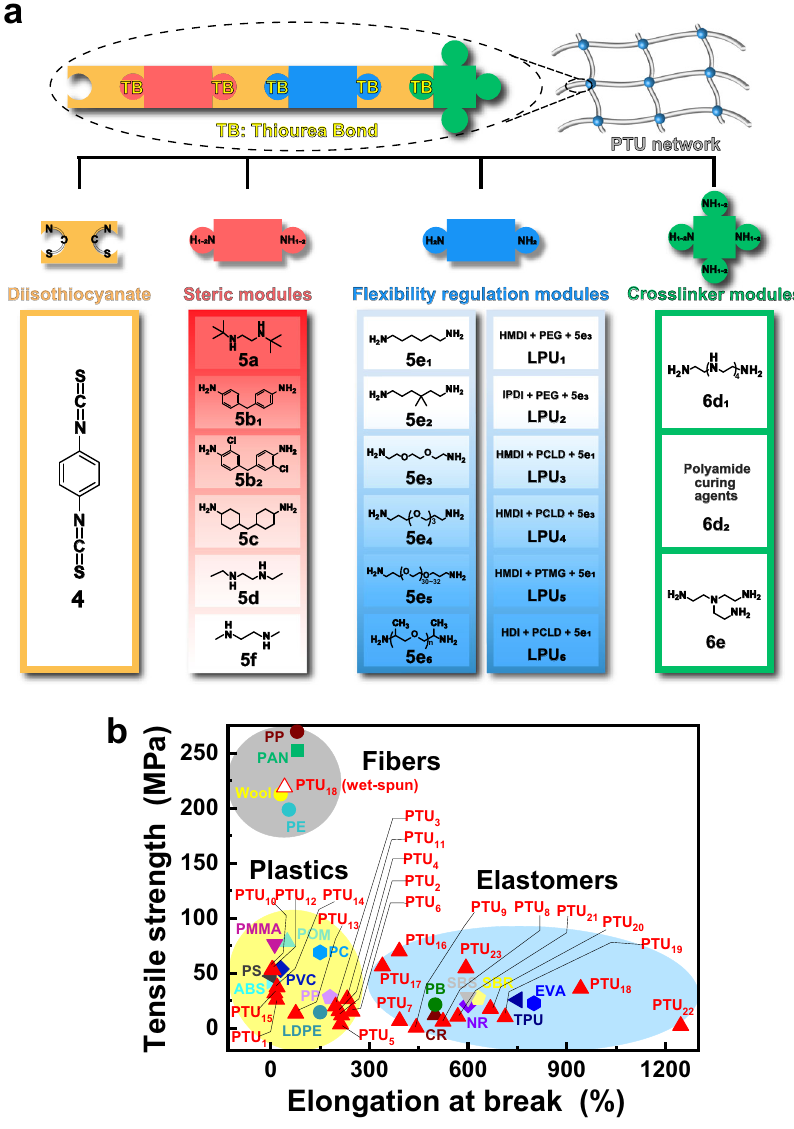
Fig. 2 Synthesis and mechanical characterization. a Modular assembly-like synthesis of crosslinked PTUs, and chemical structures of the designed modules. Note: The darker background colors of the boxes for steric modules and fl exibility regulation modules indicate larger steric hindrance, and greater ability of raising macromolecules ’ fl exibility, respectively. b Comparison of tensile properties of the crosslinked PTUs developed in this work with those of commodity plastics, elastomers and fi bers. Note: ABS acrylonitrile butadiene styrene, CR chloroprene rubber, EVA ethylene vinyl acetate copolymer, LDPE low density polyethylene, NR natural rubber, PAN polyacrylonitrile fi ber, PB polybutadiene, PC polycarbonate, PE polyethylene fi ber, PMMA polymethylmethacrylate, POM polyformaldehyde, PP polypropylene, PS polystyrene, PVC polyvinyl chloride, SBR styrene butadiene rubber, SBS styrenic block copolymers, TPU thermoplastic